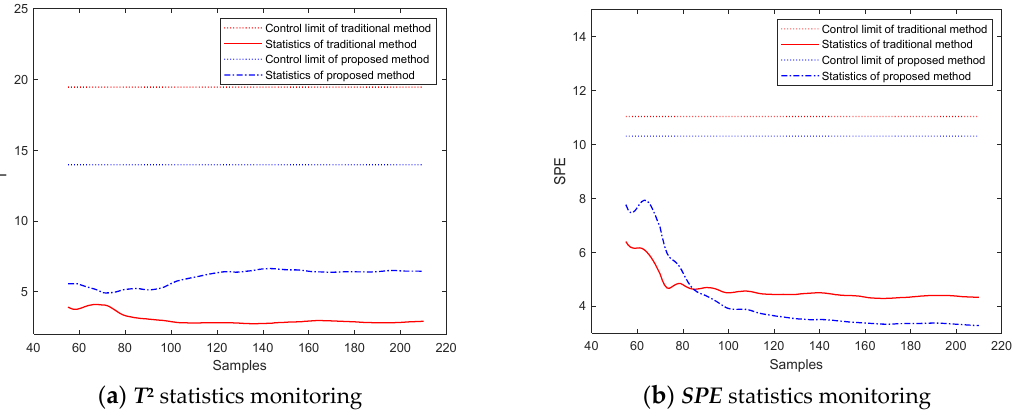
Figure 5. Single-mode online monitoring of injection phase of mode 3.